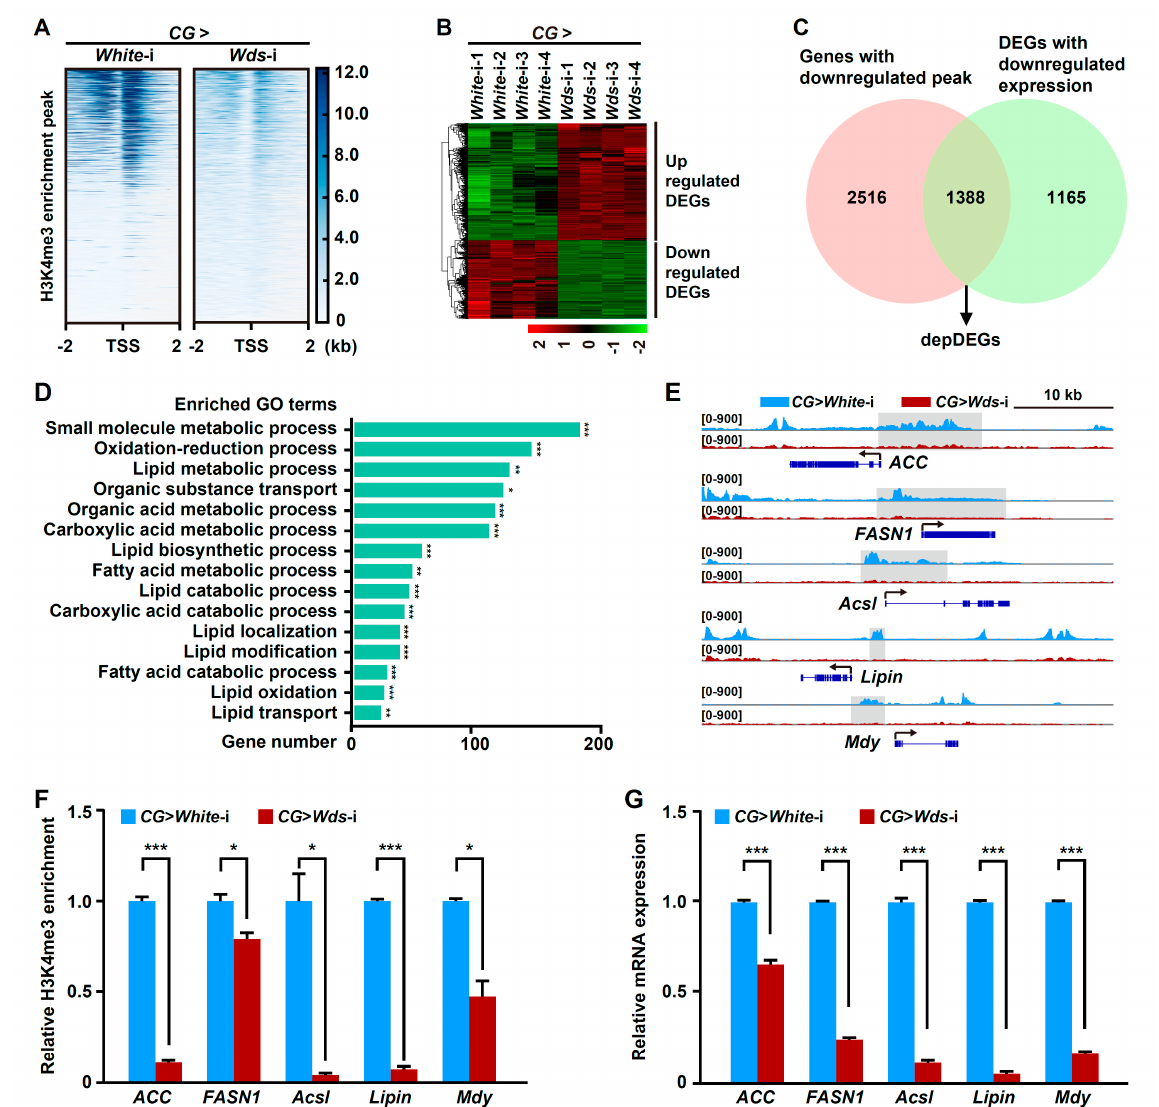
Figure 2. Fat body-specific Wds knockdown reduced H3K4me3 deposition within the promoters of lipogenic genes and impaired their transcriptions. ( A ) ChIP-seq identified the change of H3K4me3